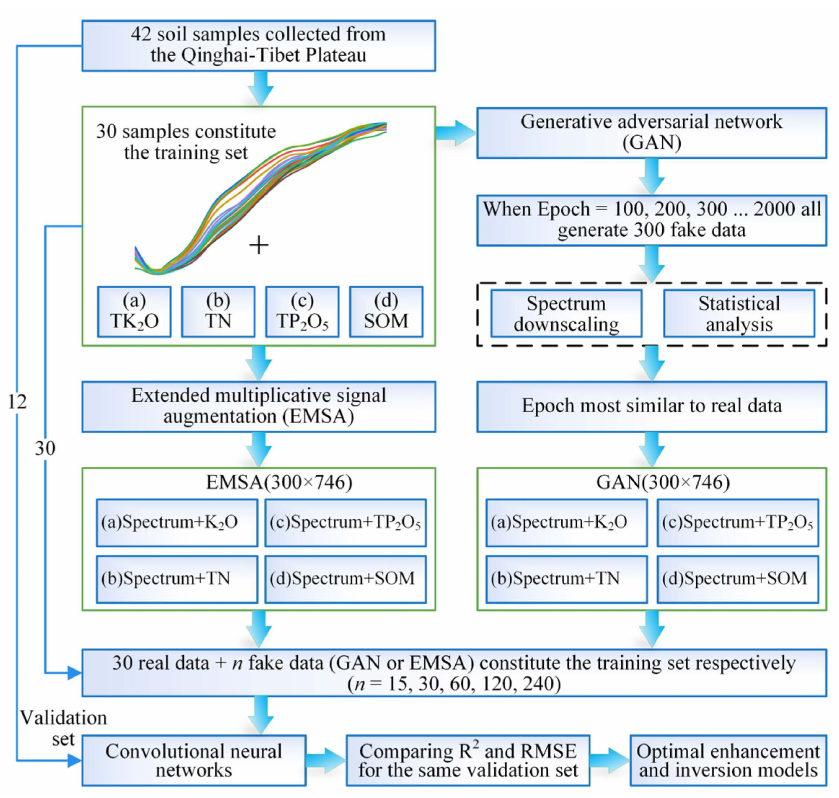
Figure 1. The technical flow chart of this